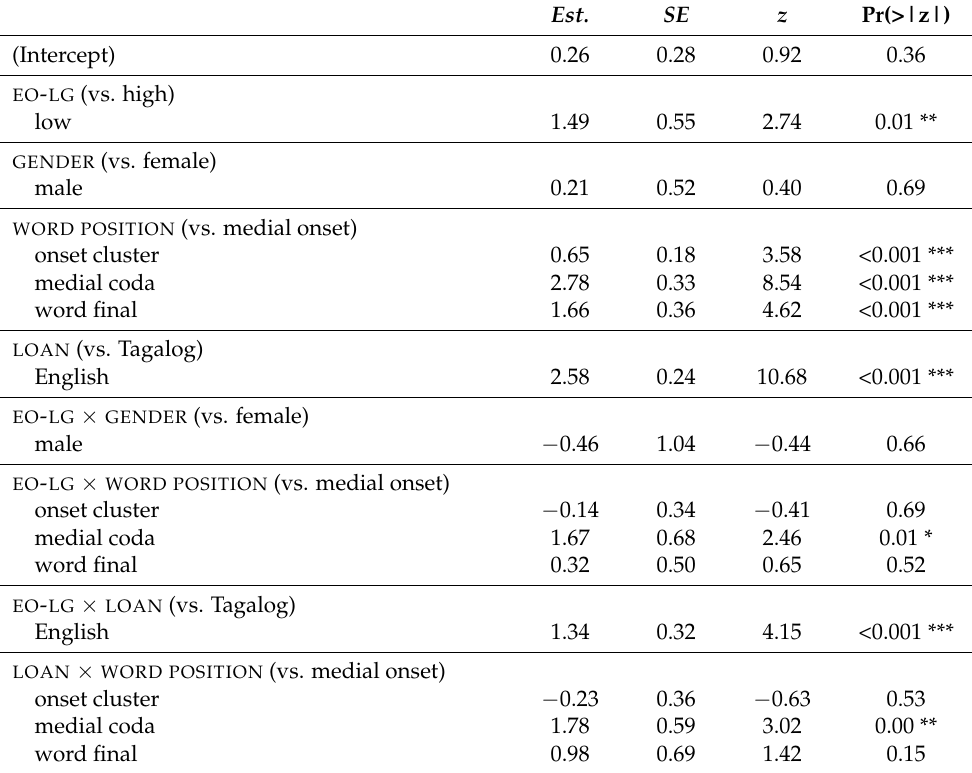
Table 11. Mixed-effects model for heritage speakers (n = 1852), comparing speakers with high EO versus low EO scores for language use/preferences. Positive estimate values indicate a favoring environment for the approximant. Significance codes: <0.001 ‘***’; <0.01 ‘**’; <0.05 ‘*’. Est. SE